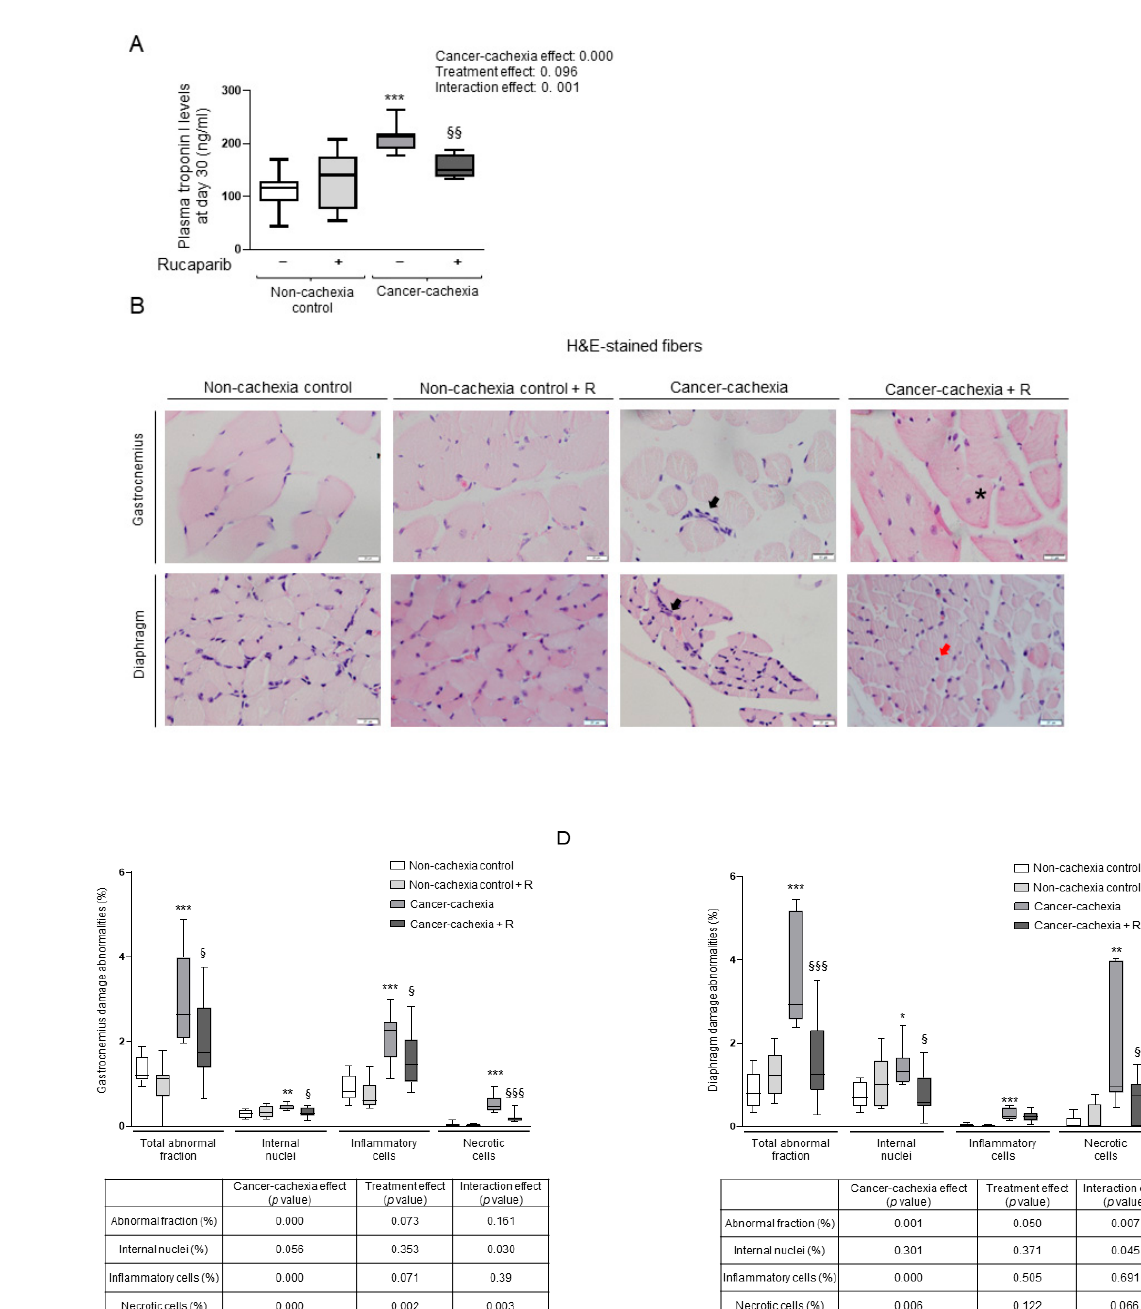
Figure 3. Box plot representation of troponin I plasma levels (ng/mL) at day 30 in all the studied groups ( A ). Representative images of muscle morphology within the gastrocnemius (top panel) and diaphragm (bottom panel) ( B ). An example of a necrotic cell (black arrow), internal nuclei (asterisk), and an inflammatory cell (red arrow) are indicated in the panels. Box plot representation of the percentage of total abnormal fraction, internal nuclei, inflammatory cells, and necrotic cells in the gastrocnemius ( C ) and diaphragm ( D ) of all experimental groups. Definition of abbreviations: R, rucaparib. H&E, hematoxylin and eosin. Statistical significance: * p ≤ 0.05, ** p ≤ 0.01, and *** p ≤ 0.001 between the untreated non-cachexia controls and the non-treated cancer cachexia mice; § p ≤ 0.05, §§ p ≤ 0.01, and §§§ p ≤ 0.001 between the cancer cachexia mice treated with rucaparib and the non-treated cancer cachexia mice. Two-way ANOVA significance ( p value) of cancer cachexia and treatment and interaction effects are also shown for each